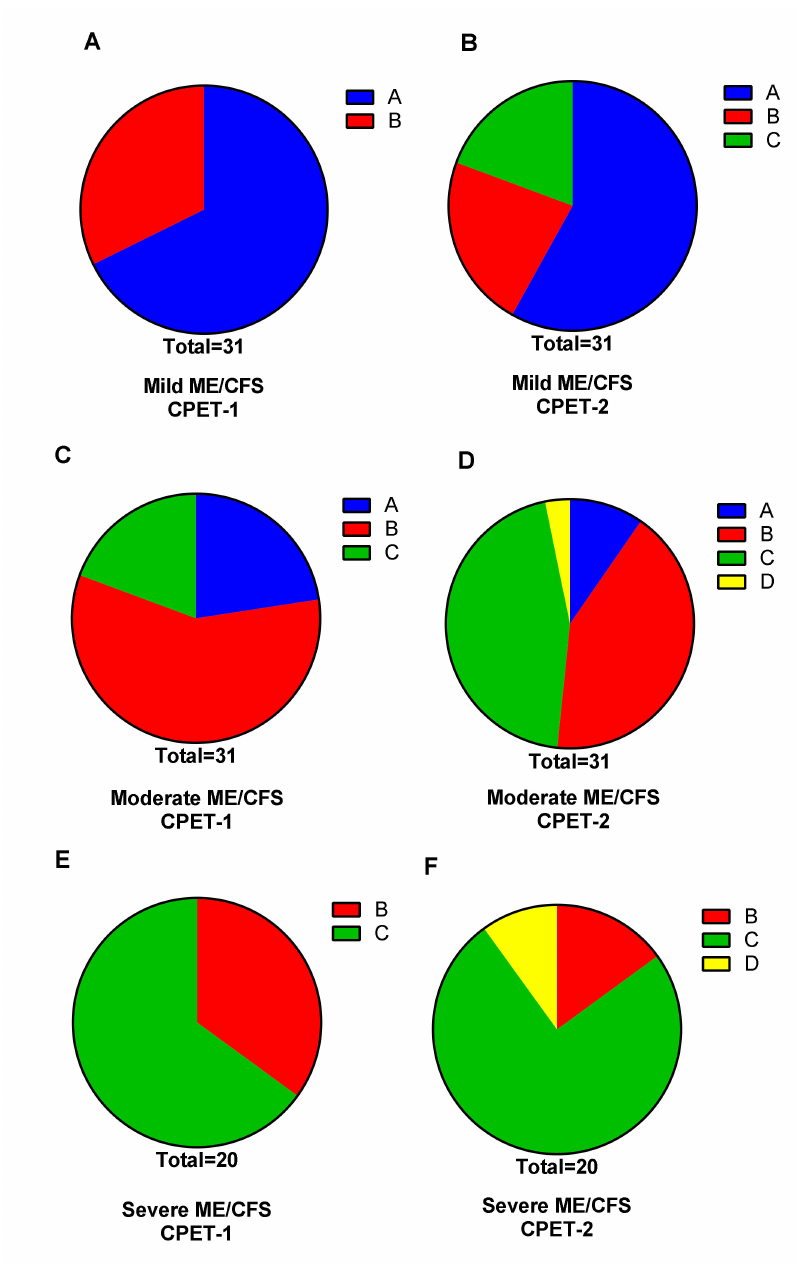
Figure 5. Disability grading according to Weber on both CPET-1 and CPET-2 for mild, moderate and severe ME / CFS patients. CPET: cardiopulmonary exercise test; Weber grading ( A ) ( > 20 mL / min / kg) (blue), ( B ) (16–20 mL / min / kg) (red), ( C ) (10–15 mL / min / kg) (green) and ( D ) ( < 10 mL / min / kg) (yellow). Panels ( A , C , E ) are representing CPET-1 for respectively mild, moderate and severe disease. Panels ( B , D , F ) are representing CPET-2 for respectively mild, moderate and severe disease